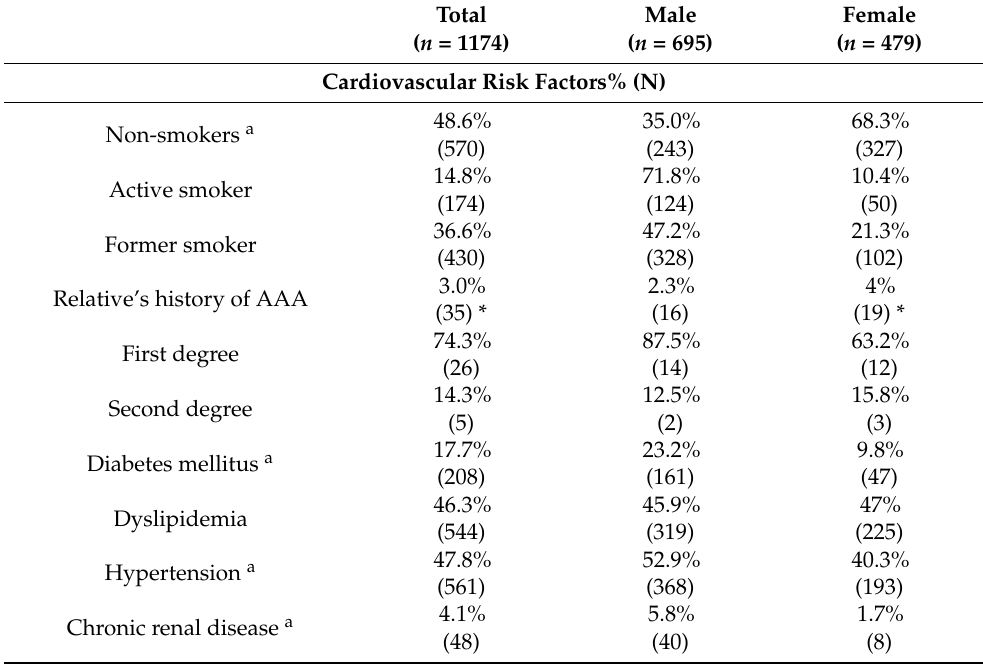
Table 4. Means and proportions of selected characteristics in the screened population separated by